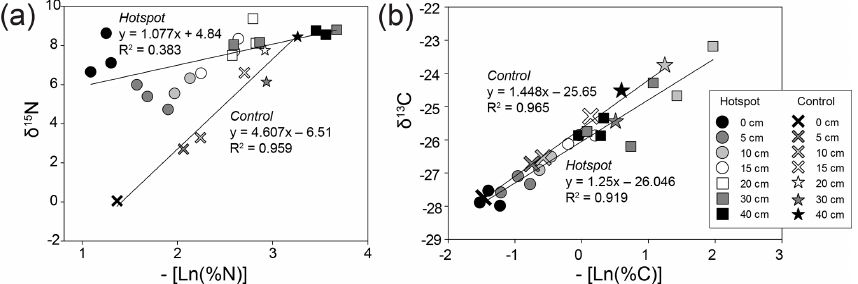
Figure 6. Bulk soil stable isotopic composition and corresponding negative natural log %N (a) and %C (b) for hotspot and control soils with depth. Linear regressions were fit to hotspot and control datasets.